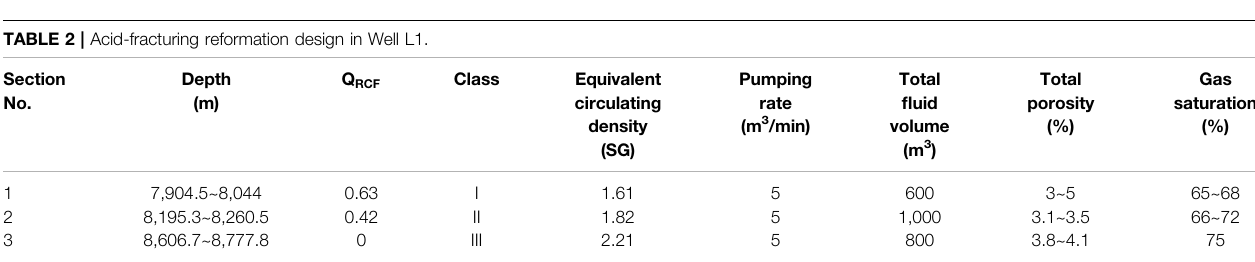
TABLE 2 | Acid-fracturing reformation design in Well L1. Section